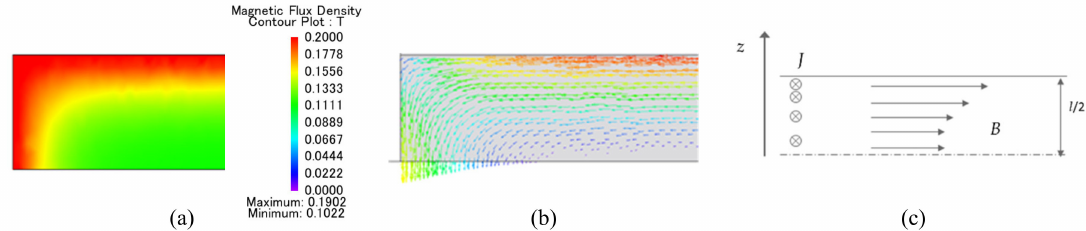
Figure 1. ( a ) Flux density profile in half a lamination of 0.3 mm when an average sinusoidal flux density is applied with an amplitude of 0.15 T at 10 kHz, ( b ) corresponding current density distribution in lamination and ( c ) 1D model for the calculation of skin e ff ect, where all parameters only depend on the